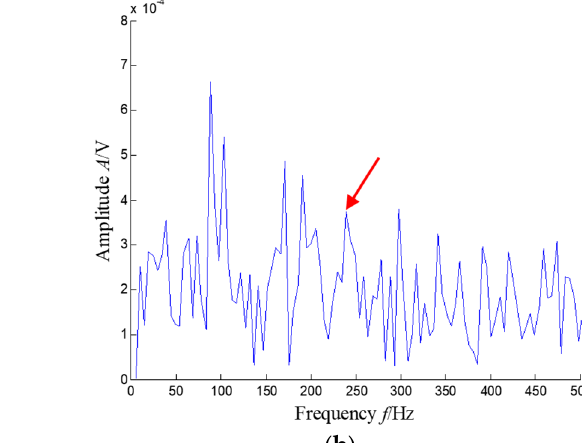
Figure 25. Spectrum and envelope spectrum of the extracted signal: ( a ) spectrum and ( b ) envelope spectrum (the fault characteristic f BPFO is highlighted by a red arrow).